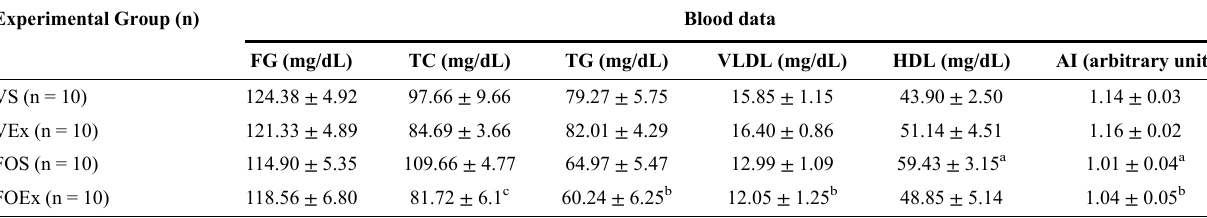
Table 1 - Glycemia, lipid profile, and atherogenic index from animals that were randomly assigned to nine pups on the first day of life, performing the exercised or sedentary experimental groups, respectively. The supplementation with fish oil (FO) or vehicle (V) was carried out from 15 up to 45 days old. Data are presented as mean ± SEM. Experimental Group (n) Blood